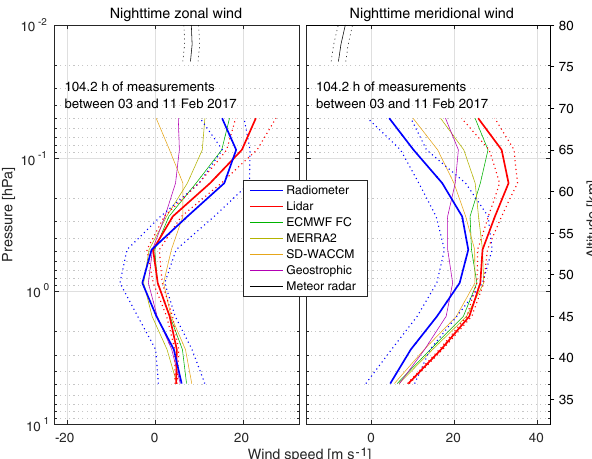
Figure 5. As Fig. 4 but for data from the time period when both instruments were operated in their respective night